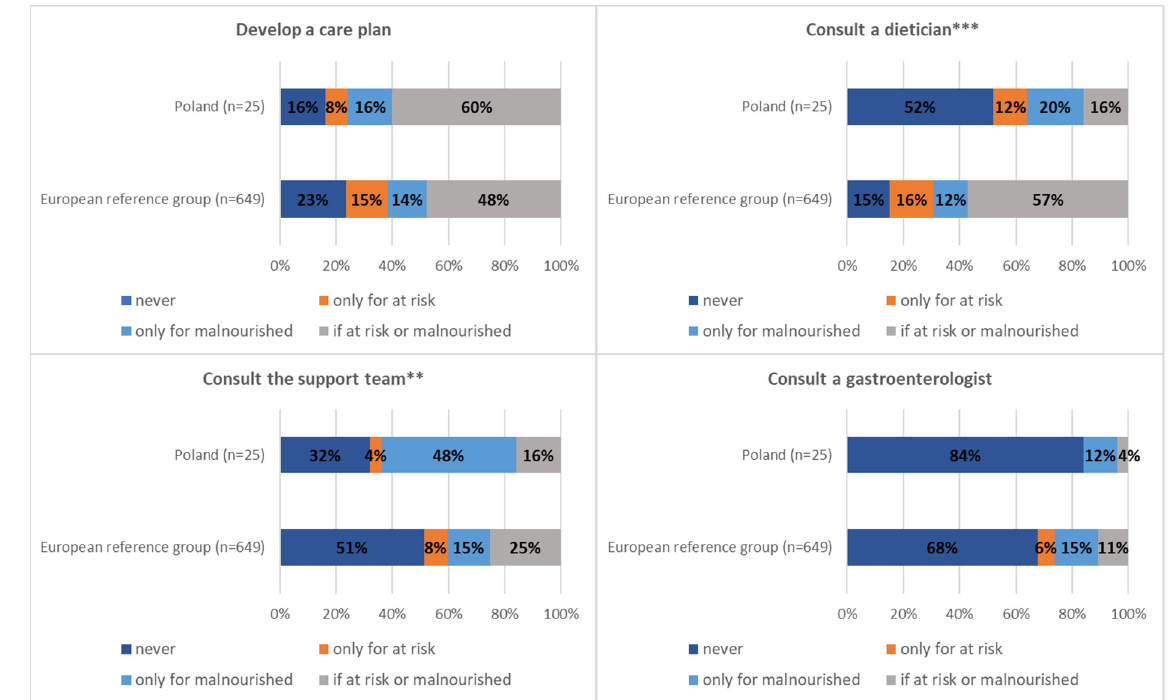
Figure 3. Structures in the wards managing malnourished/at risk of malnutrition patients in detail. ** p < 0.01 and *** p < 0.001.